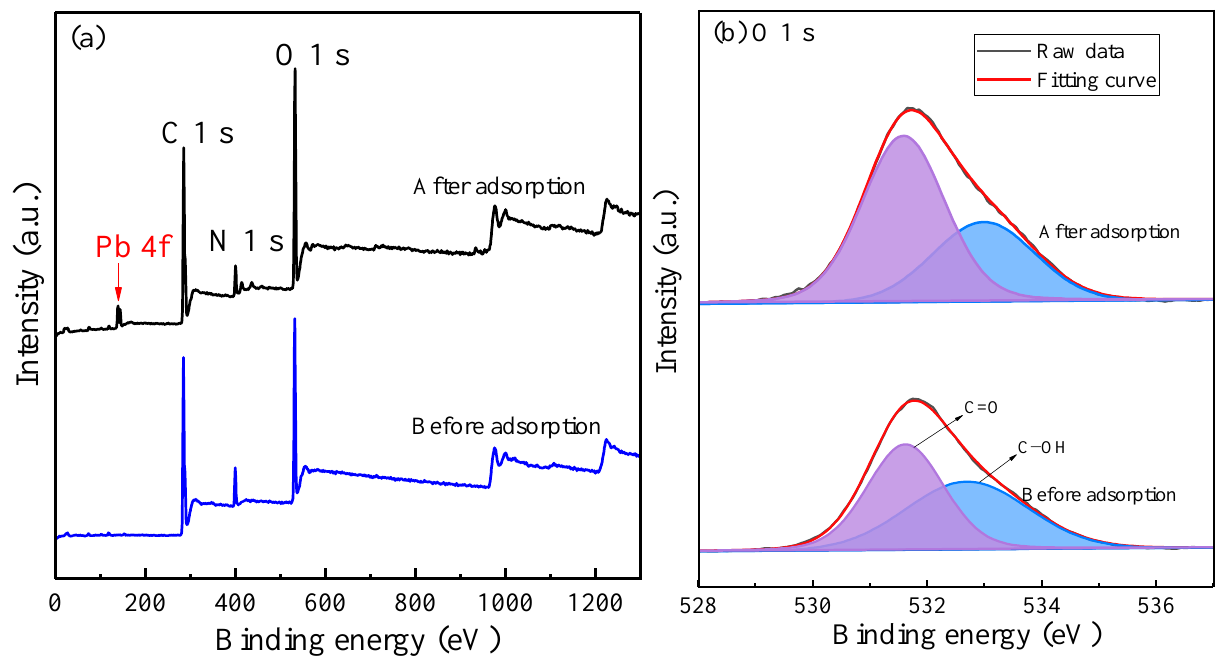
Figure 10. XPS ( a ) survey spectra and ( b ) regions of O 1 s of MT-WAO resin before and after the adsorption of Pb(II).